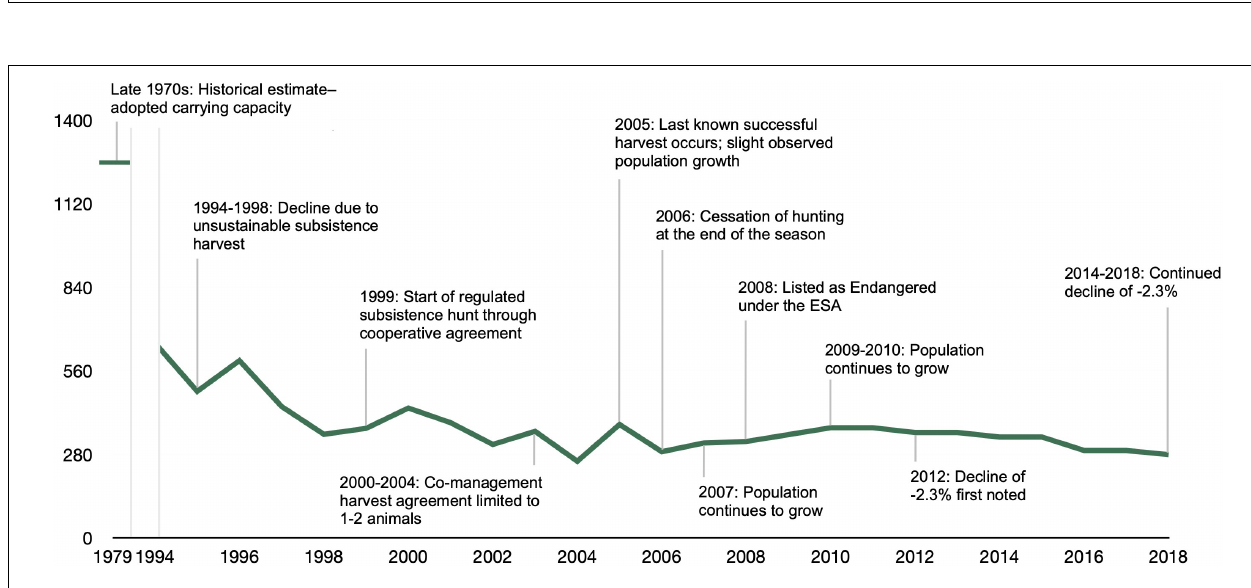
FIGURE 2 | Timeline of Cook Inlet beluga abundance estimates and population trend from 1994 to 2018. Abundance estimates for 1994–2003 were obtained from the Cook Inlet beluga recovery plan (NMFS, 2016; Table 3 ) which cited Hobbs et al. (2015a, Figure 5 ) and Shelden et al. (2015, Figure 16) as sources for this time period. The estimates for 2004–2018 were obtained from Shelden and Wade (2019) ( Table 3